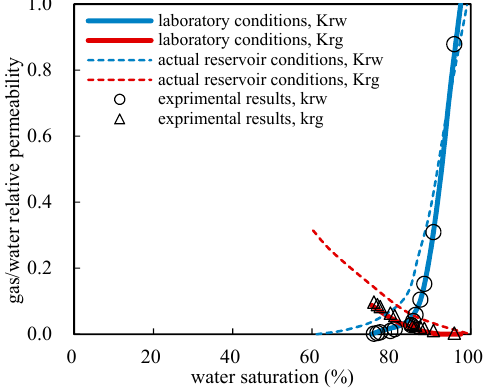
Figure 19. Gas/water relative permeability curves of core 69 #.